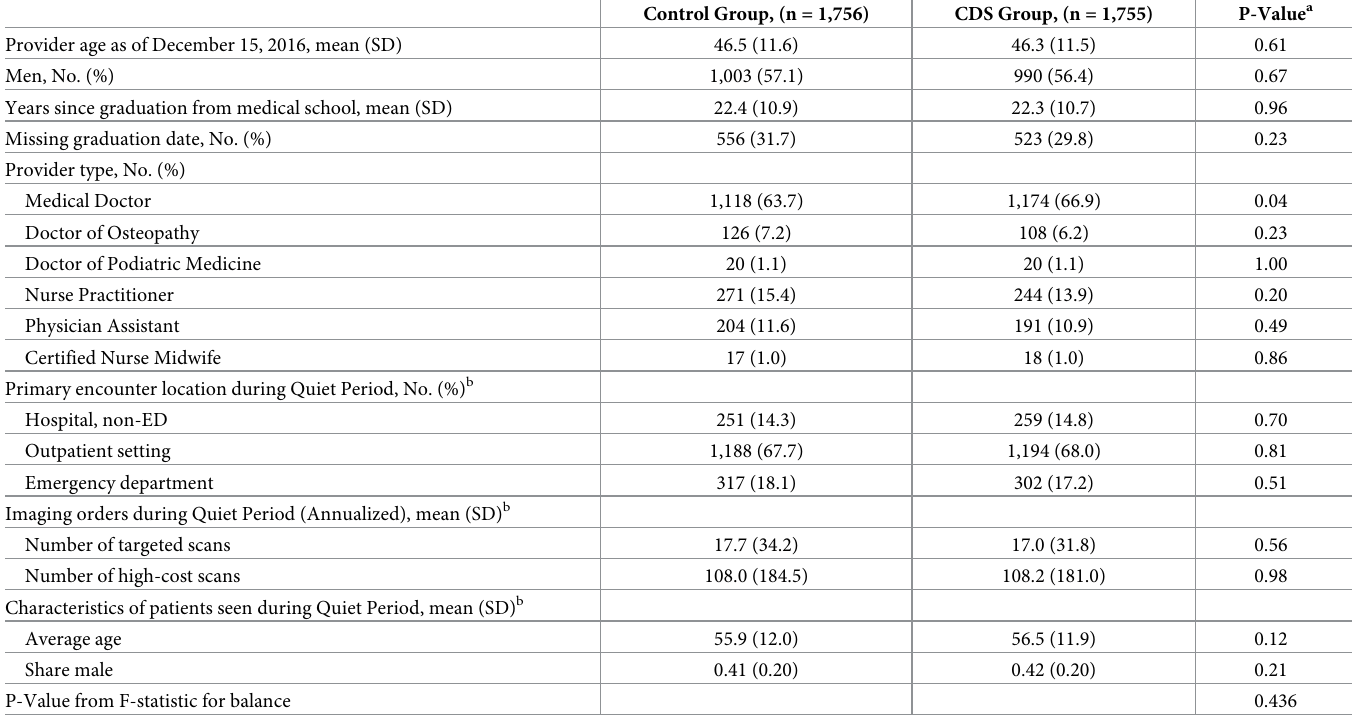
Table 1. Provider characteristics.